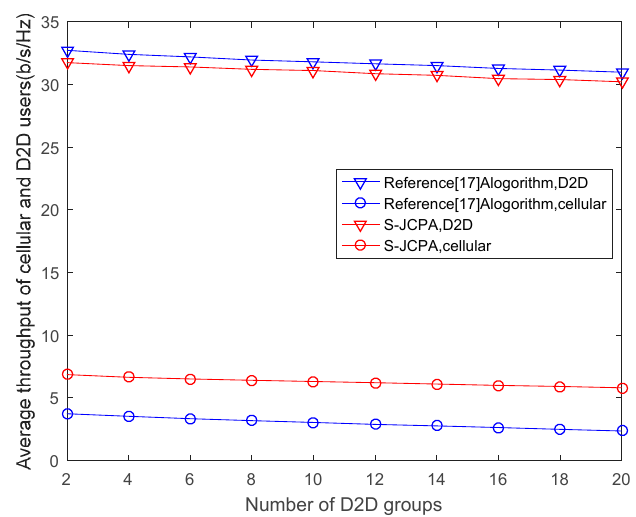
Figure 4. Average throughput of cellular and D2D users for di ff erent algorithms with di ff erent numbers of D2D groups, M = 20, S k m , n ∼ ( 0, 1 ) .